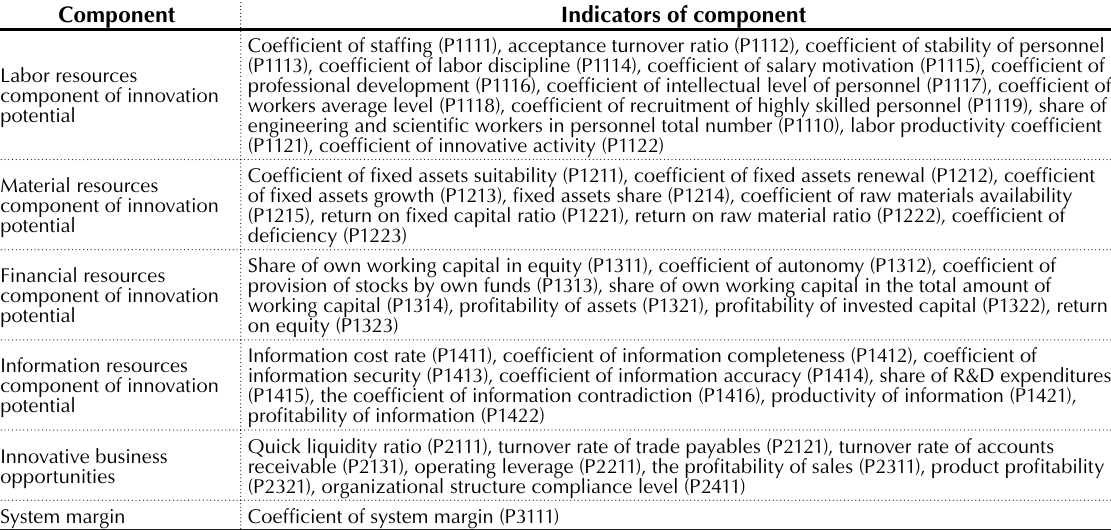
Table 2. Indicators of company’s innovation capability Component Indicators of